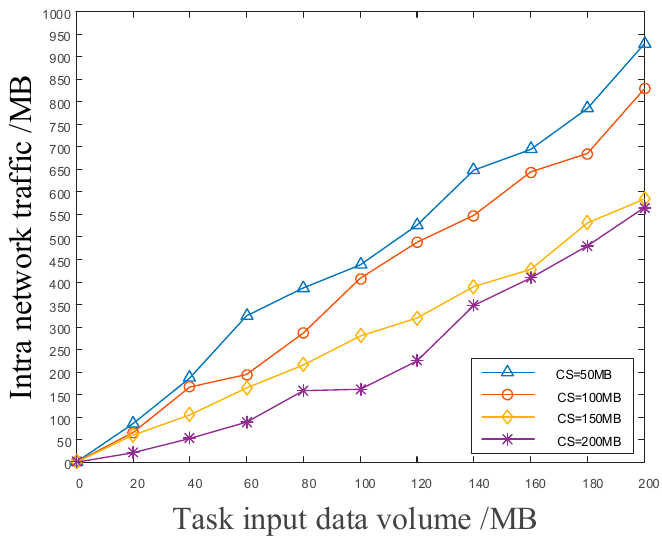
Figure 10. The diagram of the effect of on-board cache capacity on network traffic.